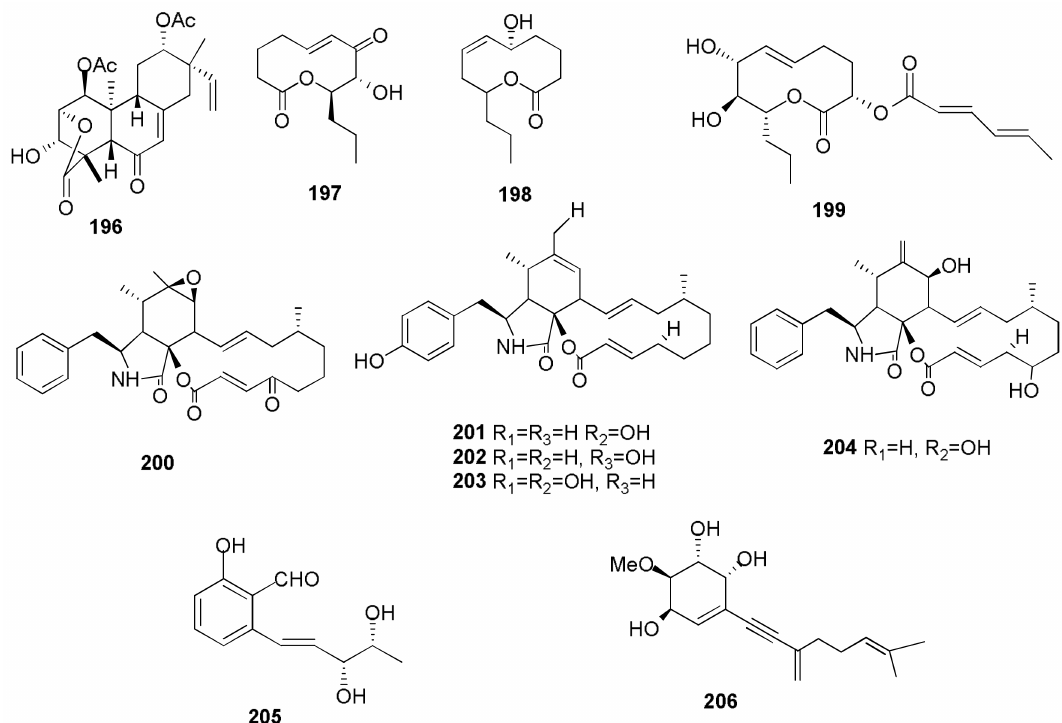
Figure 14. The structures of chenopodolin ( 196 ); stagonolide ( 197 ); putaminoxin ( 198 ); pinolidoxin ( 199 ); cytochalasins F, T, Z1, Z2, and Z3 ( 200 – 204 ); agropyrenol ( 205 ); and phomentrioloxin ( 206